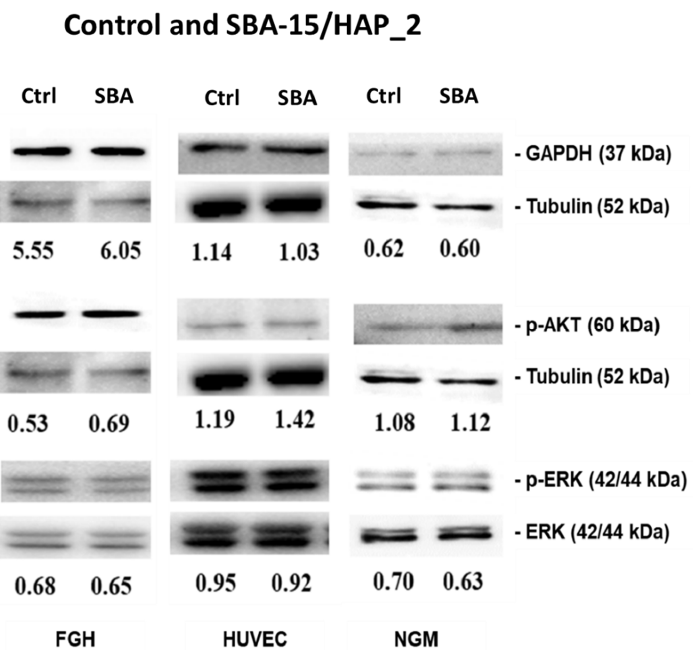
Figure 10. Immunoblotting analysis of human cells exposed to SBA-15/HAP_2 mesoporous silica to evaluate the influence on cell signaling by observing the AKT, p-AKT, ERK, p-ERK, GAPDH, and